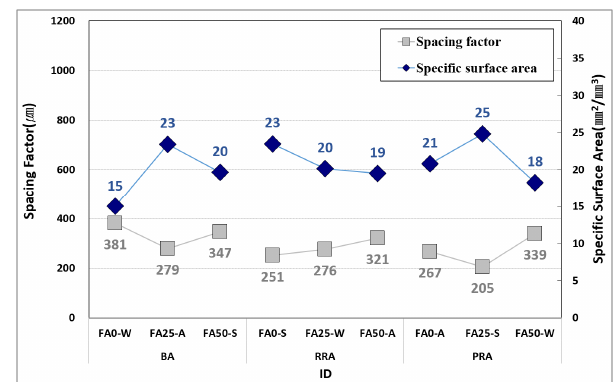
Materials 2022 , 15 , x FOR PEER REVIEW Figure 15. Pore distribution of hardened concrete. Figure 15. Pore distribution of hardened concrete.